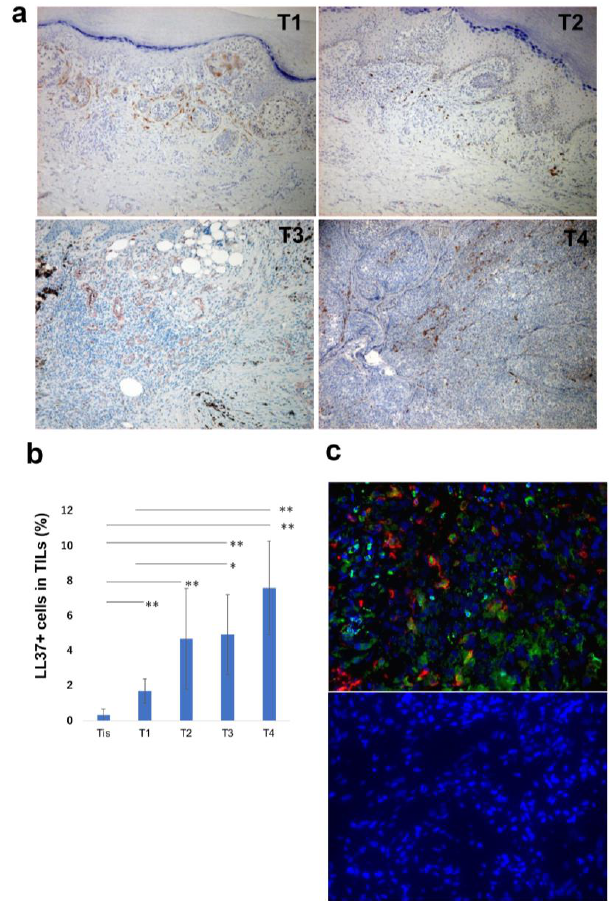
Figure 1. Representative paraffin-embedded tissue samples from lesional skin of patients with melanoma in each tumor stage ( a ). Quantitative analysis of LL-37+ cells: the IHC-positive cells within the lymphocyte fraction and the percentage of IHC-positive cells per all tumour-infiltrating cells were automatically counted using a BZ-X800 microscope ( b ). IF staining of melanoma for LL-37 (green), CD163 (red), and DAPI (blue, nuclei). A merged image is also shown, with green and red combining into yellow. The isotype control IgG1 stains as red or green ( c ). * marks a significant ( p < 0.05) difference. ** marks a significant ( p < 0.01) difference.